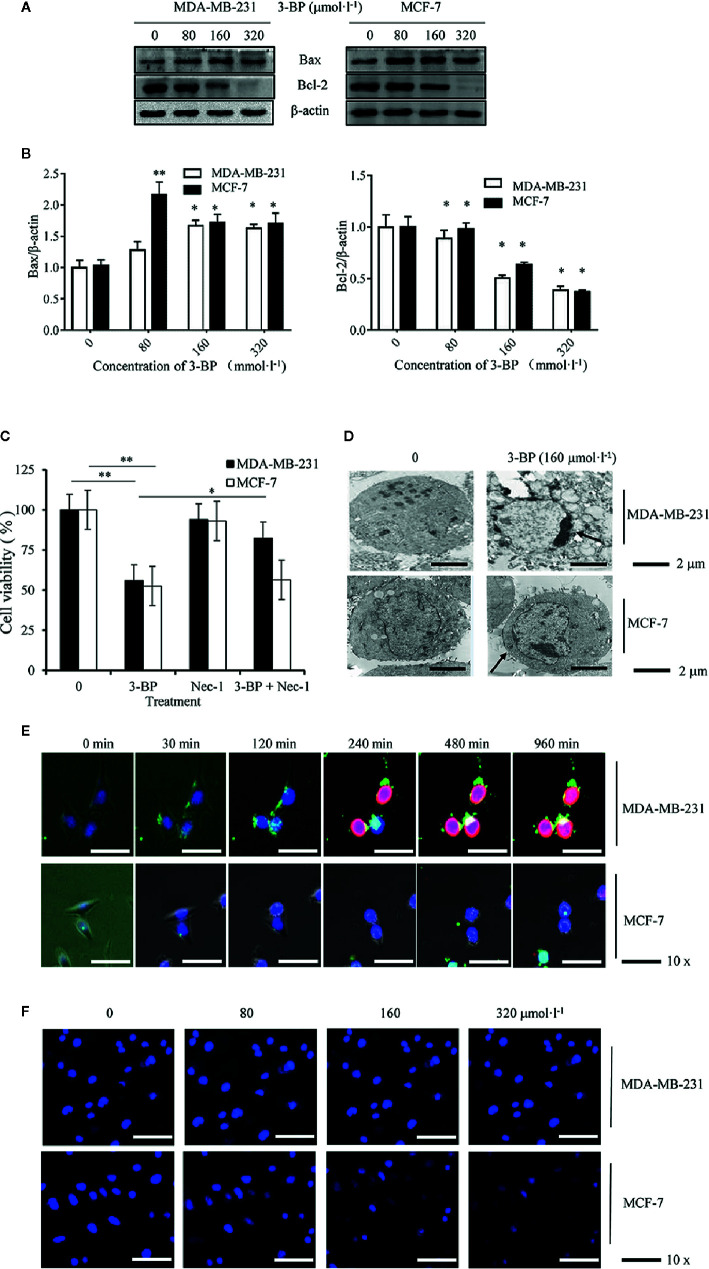
Cellular apoptosis and necroptosis induced by 3-BP in breast cancer cells. (A, B). Apoptosis-related proteins were detected after cells were treated with 3-BP for 24 h, and were analyzed by western blotting. β-actin served as the loading control. (C). Cells were treated with 3-BP or 3-BP combined with Nec-1 for 24 h, and cell viability was determined using MTT assay. (D) Cells were treated with 3-BP (0, 160 μmol·l-1) for 24 h and then prepared for Electron Microscopy analysis. Scale bar: 2 μm; (E) Cells were treated with 3-BP (0, 160 μmol·l-1), and observed under a live-cell workstation microscope for 24 h persistent observation. (F). Cells were treated with 3-BP (0, 80, 160, 320 μmol·l-1) for 24 h, subjected to DAPI staining and then visualized under a fluorescence microscope. *P < 0.05, **P < 0.01.